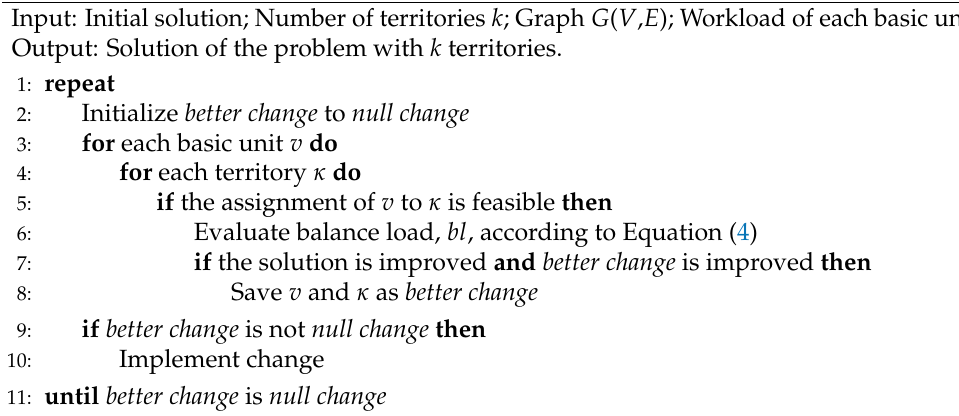
Algorithm 2 Description of the local search